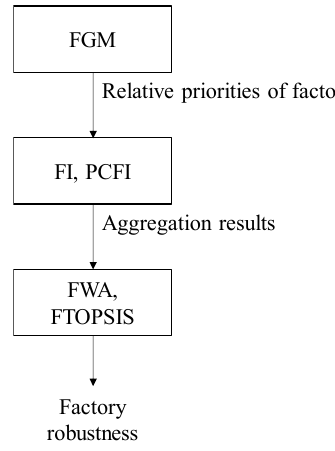
Figure 3. The main parts of the proposed methodology.